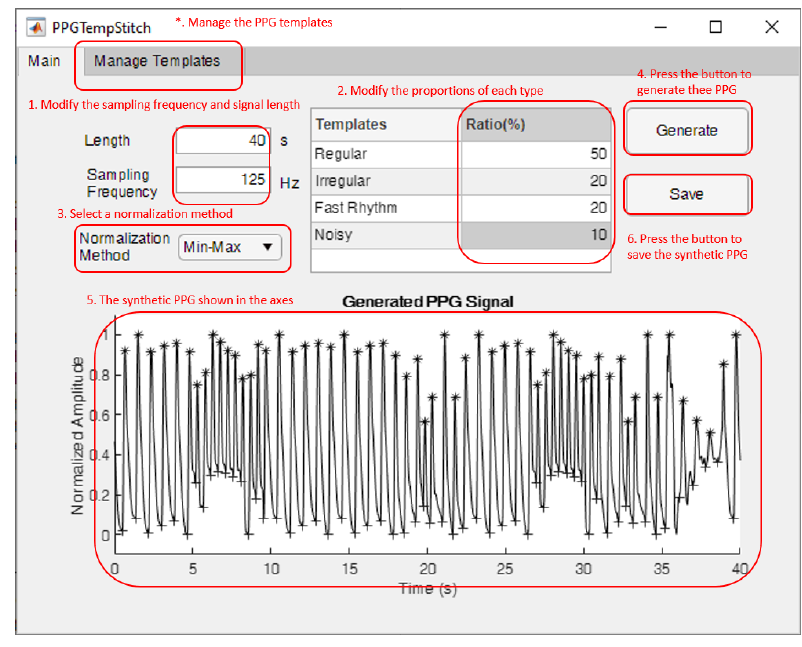
Figure 5. The graphical interface of